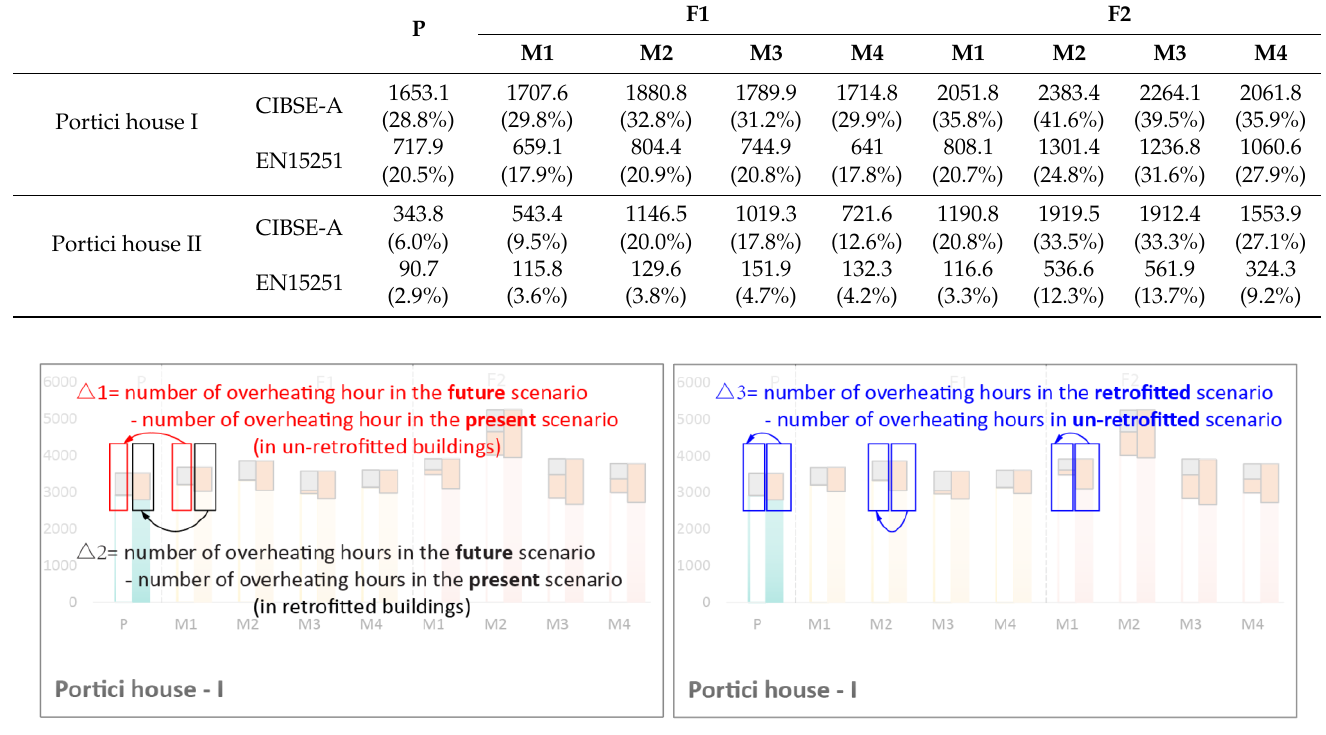
Figure 12. Three parameters (Δ1–Δ3) defined to analyse the impact of climate change and retrofit interventions on overheating. Example for Portici house-I. Table 8. Increased risk of overheating (in hours per year) in the living room due to climate change and retrofit interventions according to EN15251. P = 2008–2018, F1 = 2041–2050, F2 = 2091–2100; M1-4, refer to the climate models in Table 2. For each reference building, the colour of tables switches from green to red according to the increment in